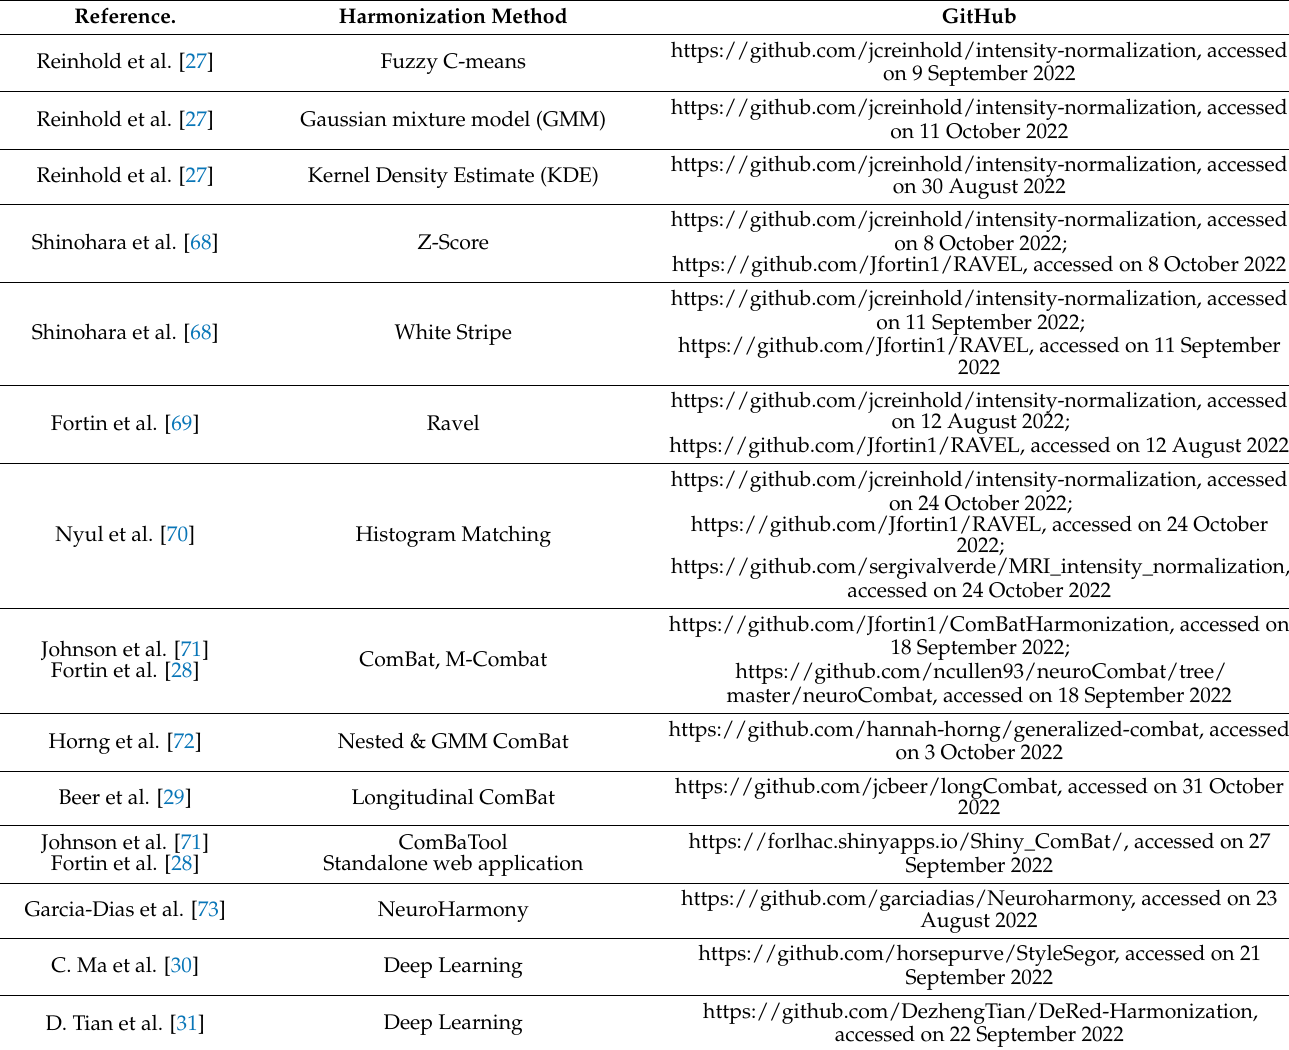
Table 2. Harmonization techniques publicly available on